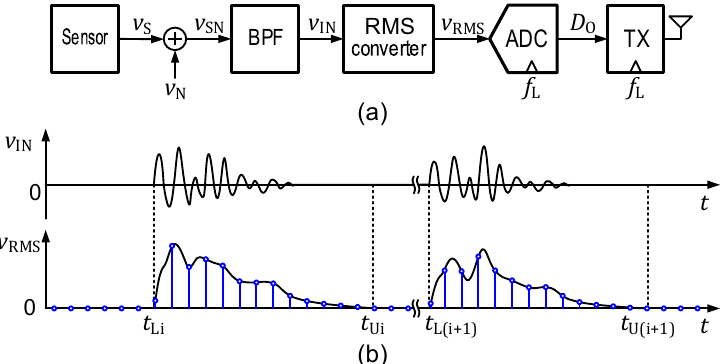
Figure 4. Conventional low-speed monitoring system with RMS converter. ( a ) Block and ( b ) timing diagrams.